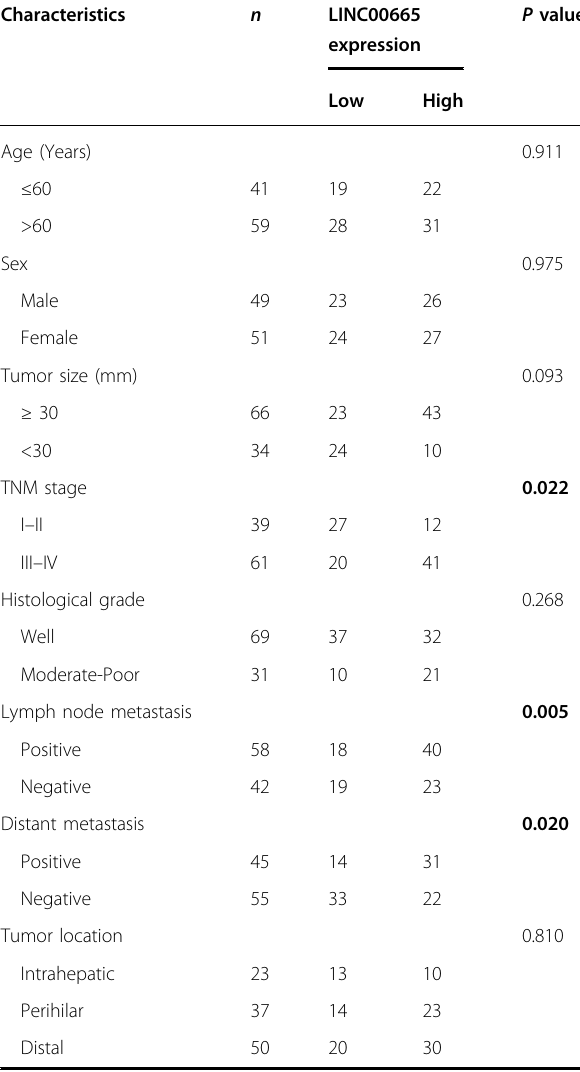
Table 1 Correlation between LINC00665 expression and clinicopathological characteristics in cholangiocarcinoma